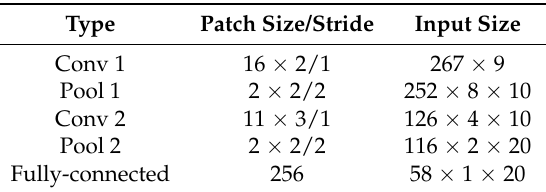
Table 1. Model configuration for the